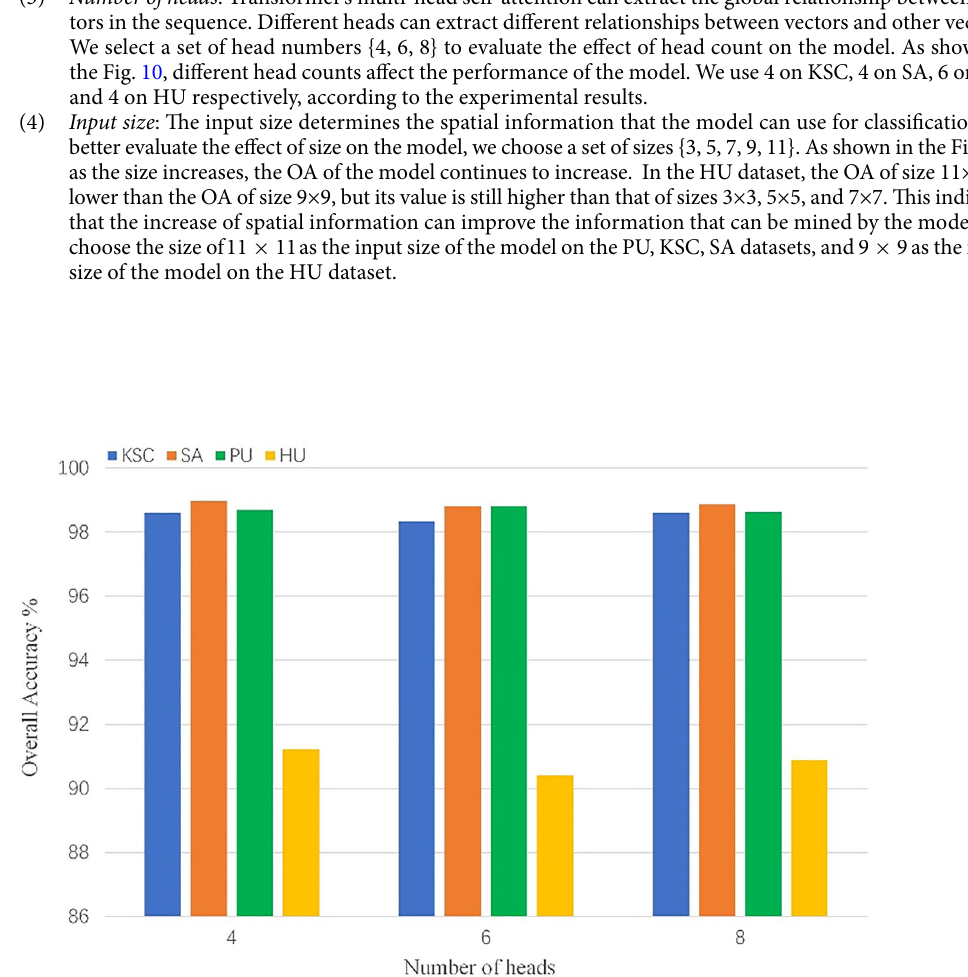
Figure 10. OA (%) of DBFFT with different number of heads in the four